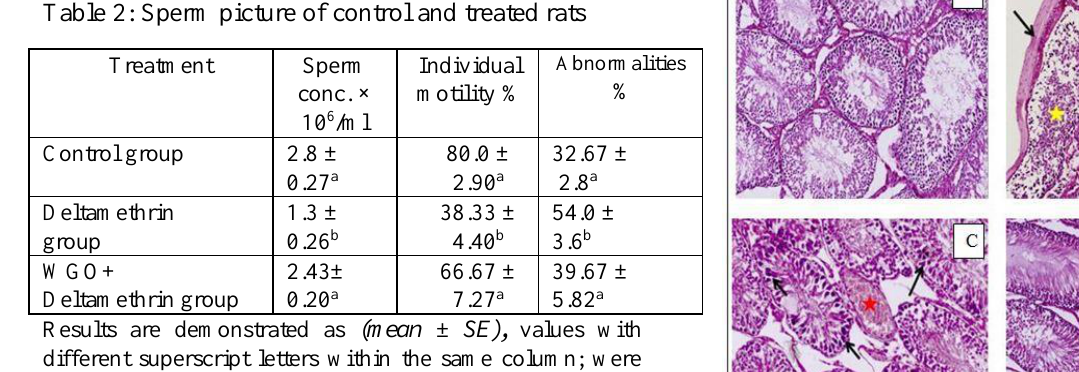
Table 2: Sperm picture of control and treated rats